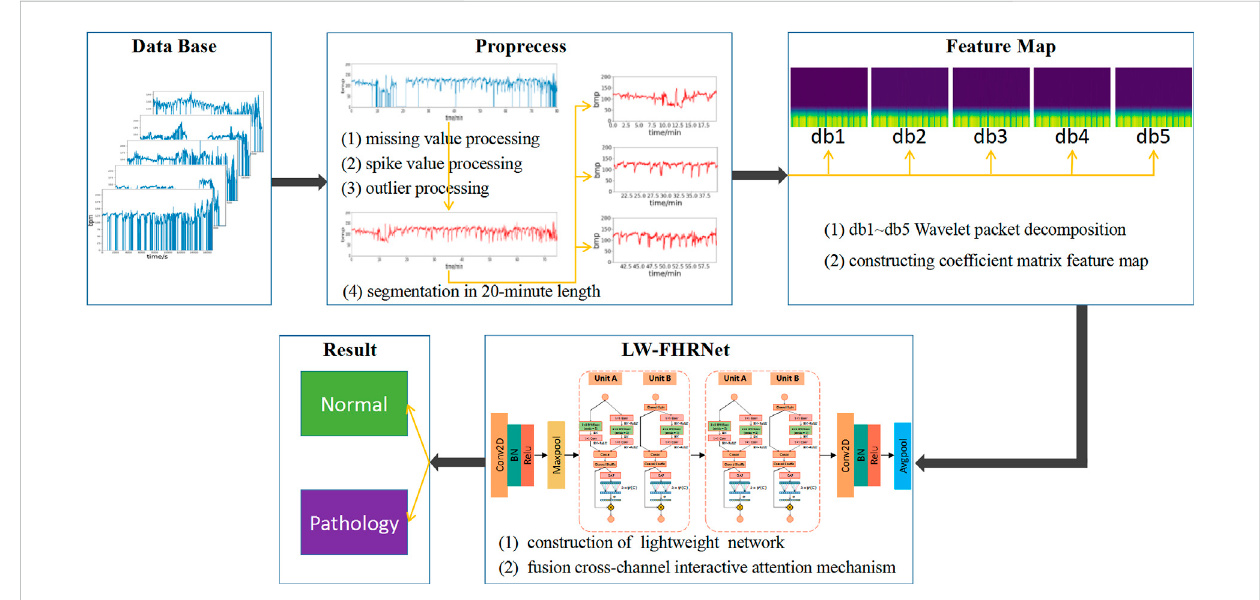
FIGURE 1 Description of the architecture for the proposed lightweight network-based fetal distress assisted-diagnosis